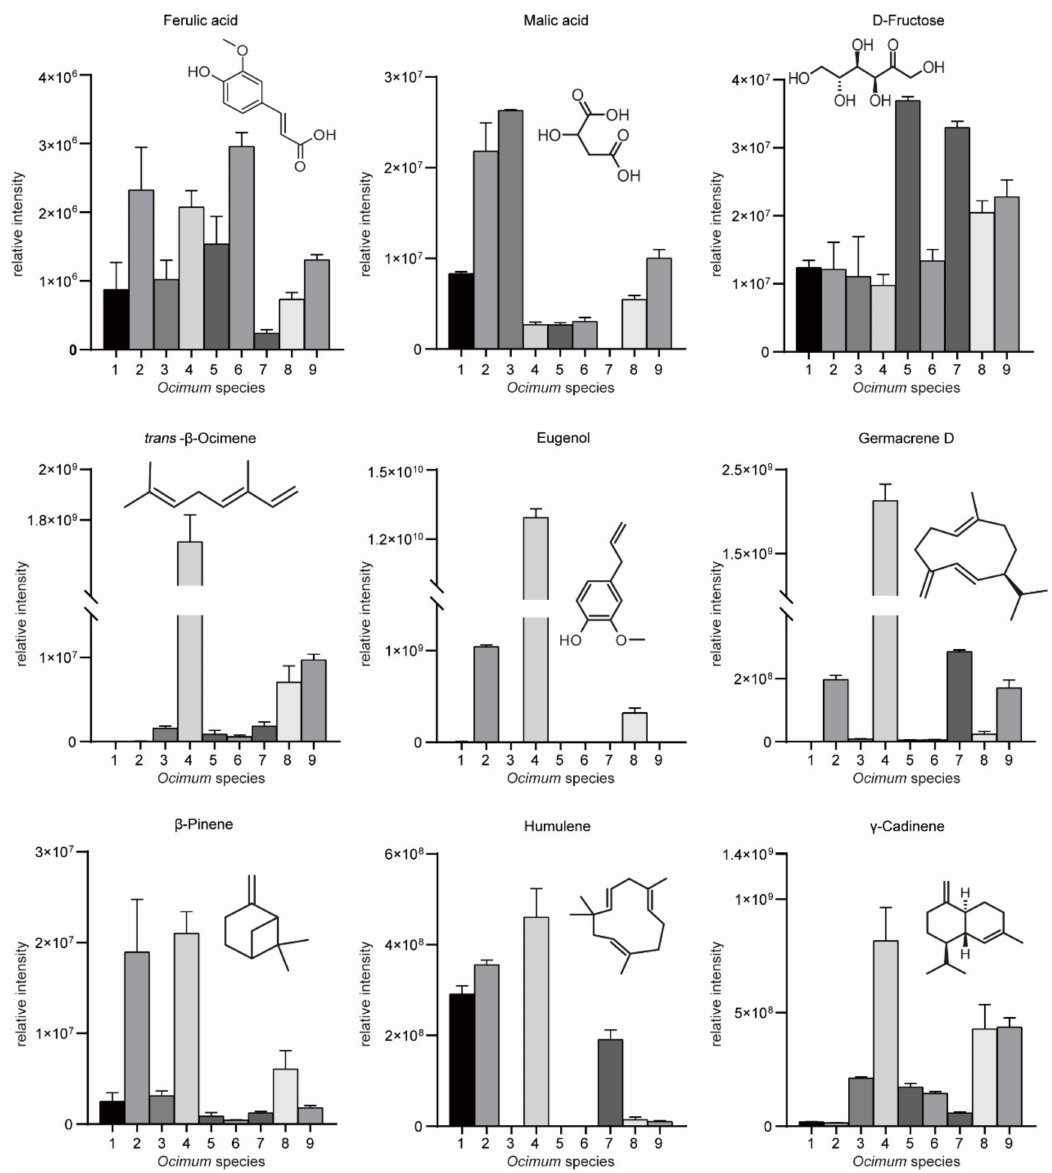
Figure 4. Relative intensities of key aromatic/flavor compounds in basil identified in this